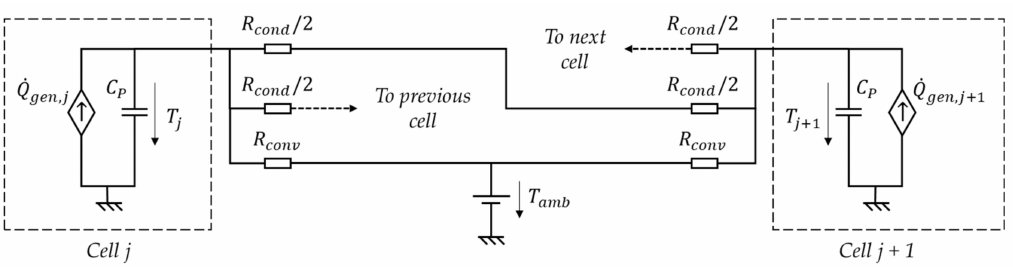
Figure 12. TECM of cell j with links to neighboring